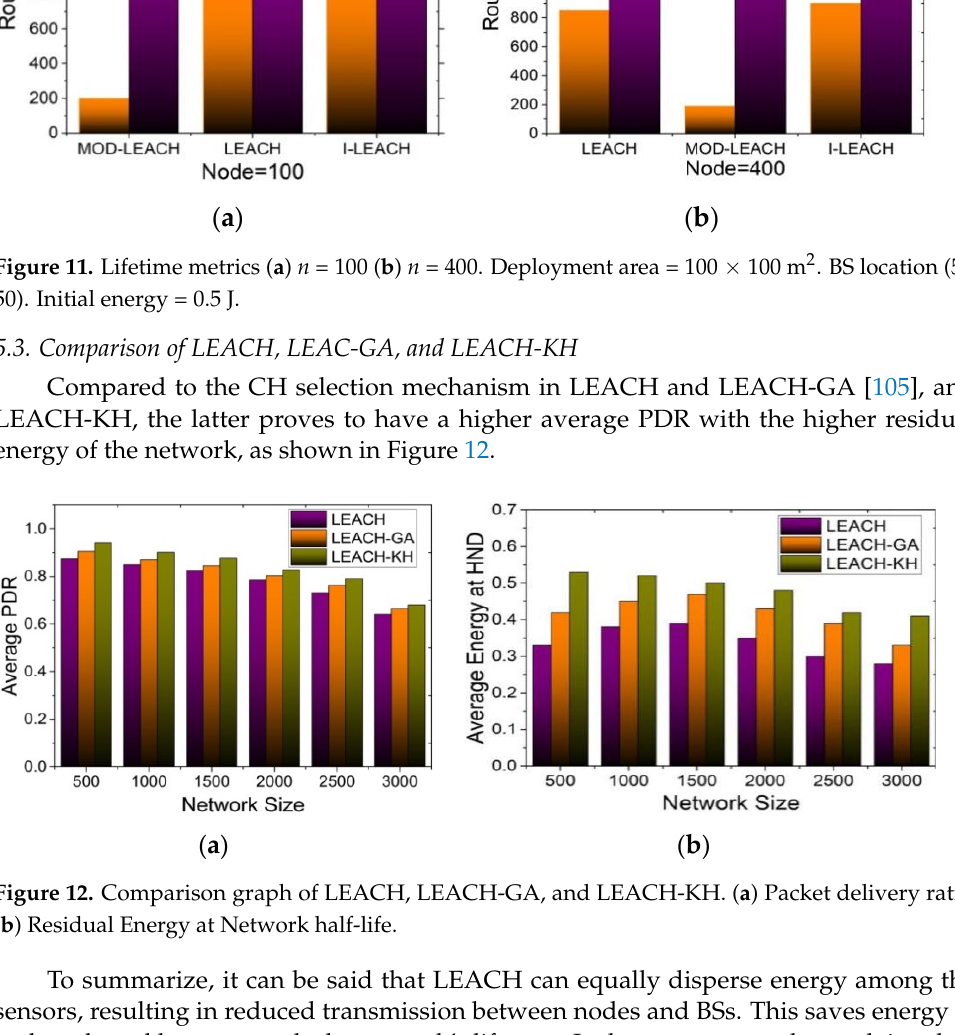
Figure 10. Lifetime metrics comparison for BS location (50,175).